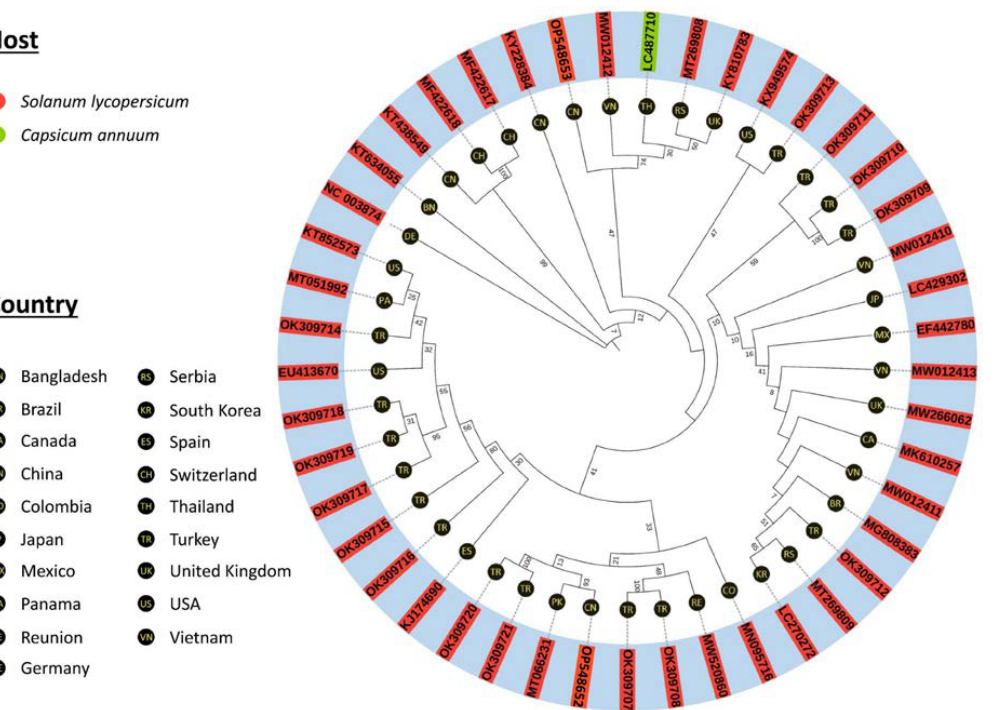
Figure 4. Molecular phylogenetics of STV demonstrated the evolutionary relatedness between the species of the genus Amalgavirus in the family Amalgaviridae . A phylogenetic radial tree was constructed on the basis of the complete genome sequence STV. The isolates are represented in the radial tree with accession numbers of the sequences and reported regions. All 44 STV isolates deposited in GenBank were used to analyze the phylogenetic relationships of isolates found in Beijing, China (OP548653 and OP548652), and Punjab, Pakistan (MT066231). They had close relationships with Asiatic, American, and European isolates.